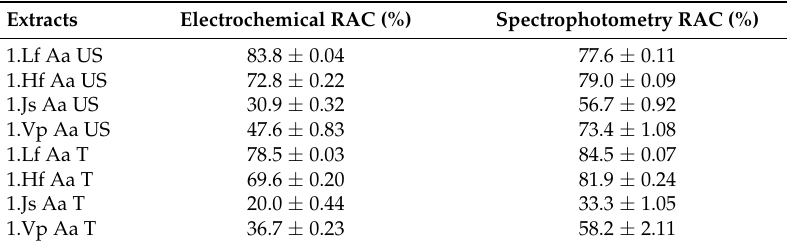
Table 3. RAC (%) for alcoholic plant extracts.